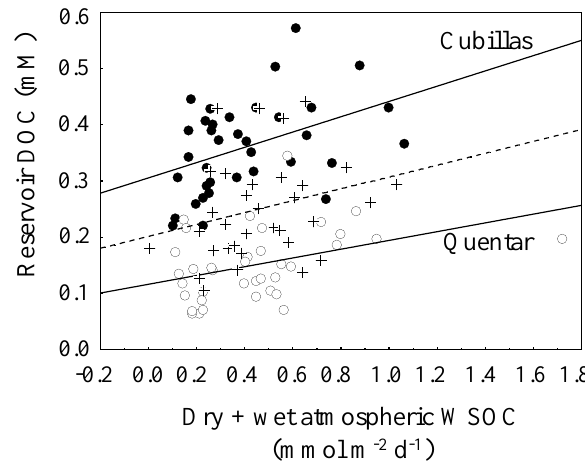
Fig. 5. Relationships between total (dry + wet) atmospheric WSOC inputs (mmolm − 2 d − 1 ) and DOC concentrations (mM) in the reser- voirs merging data for both study years. Solid lines are shown for significant relationships ( p < 0.05) in Cubillas (solid circles) and in Qu´entar (empty